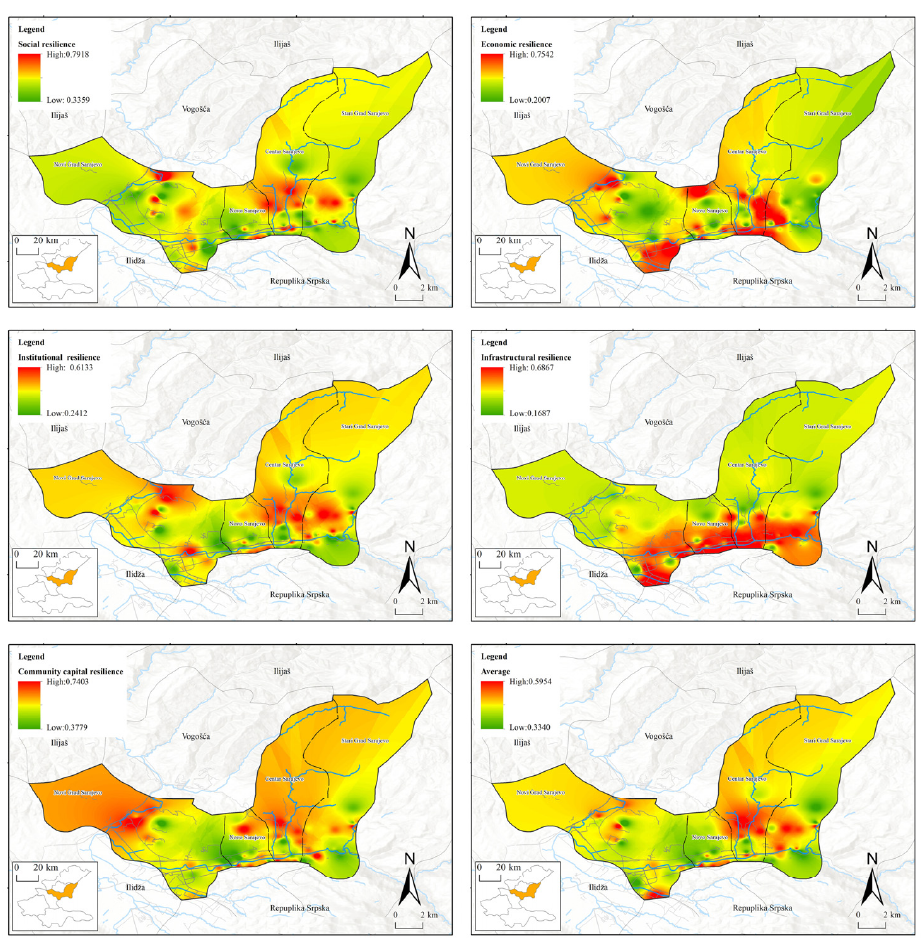
Figure 4. Distribution map of perceived resilience in different dimensions in Sarajevo.